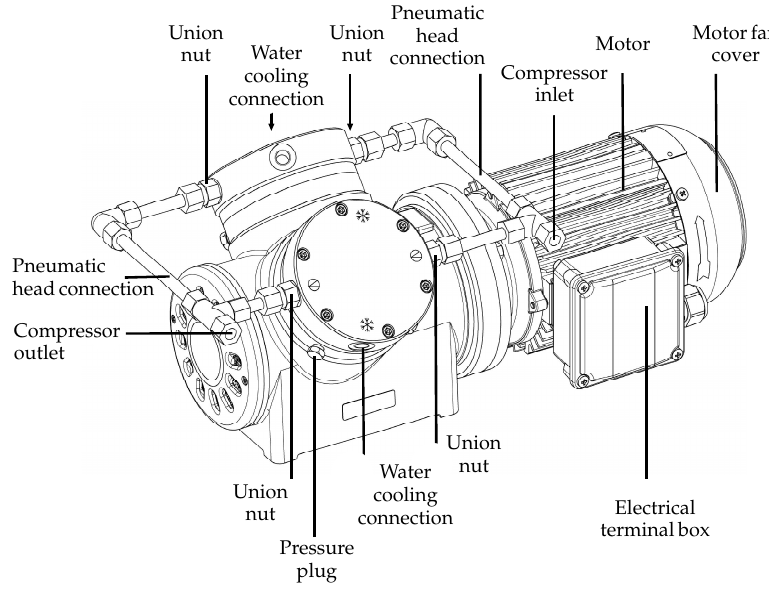
Figure 4. A 3-D representation of a schematic diagram of a KNF compressor and its component.